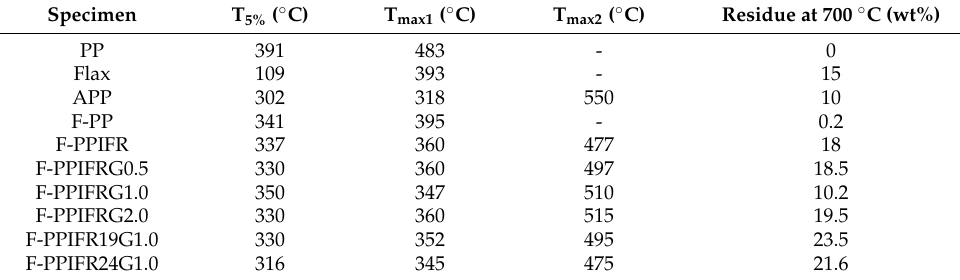
Table 2. TGA results of PP, Flax, APP and various composites.